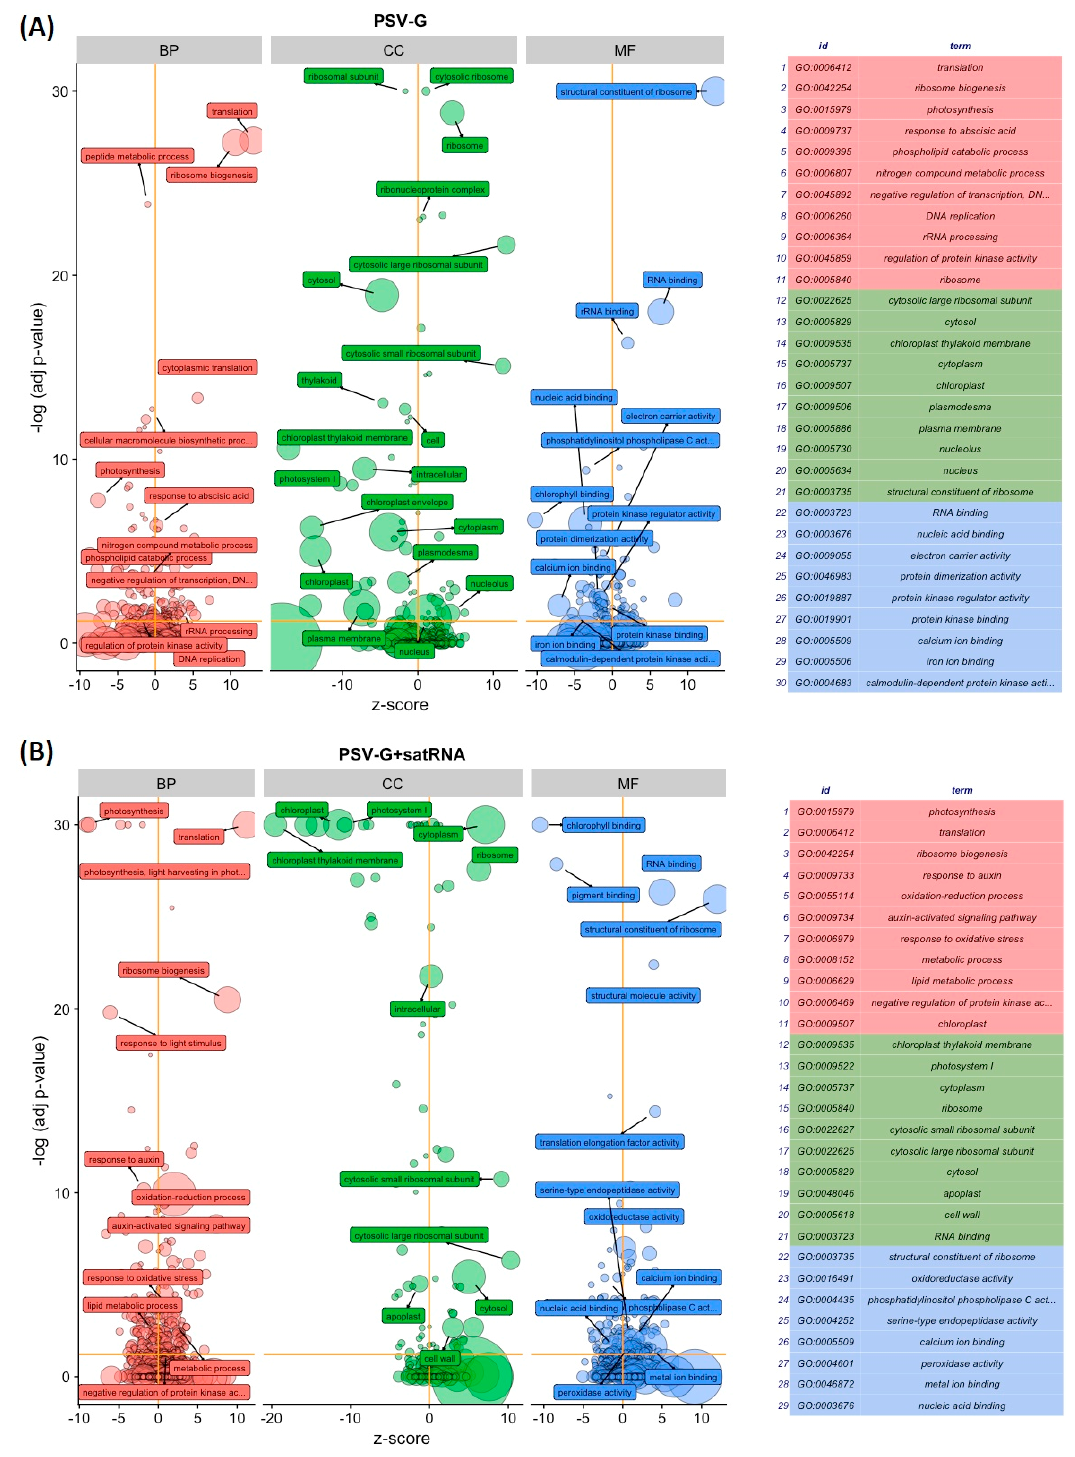
Figure 7. Gene ontology terms for DEGs of Nicotiana benthamiana infected with PSV-G ( A ) and PSV + satRNA ( B ). The z-score was assigned to the x-axis and the negative logarithm of the adjusted p -value to the y-axis (the higher the more significant). The area of the displayed circles is proportional to the number of genes assigned to the term and the color corresponds to the three categories: Biological Process (BP, red), Cellular Component (CC, green) and Molecular Function (MF, blue). The circles were labeled with the GO term name. On the right side a table connecting the IDs and terms is displayed. Only some of significant circles were labelled due to the limited space and the overlap of the circles. A threshold for the labeling was set based on the negative logarithm of the adjusted p -value (>1.3 which gives only GO terms that are significant at the 0.05